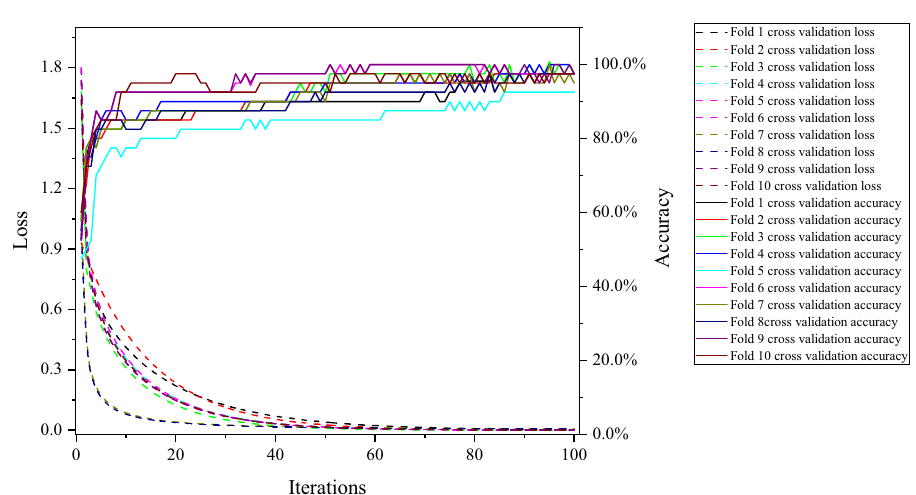
Figure 4. The training chart of tenfold cross-validation.